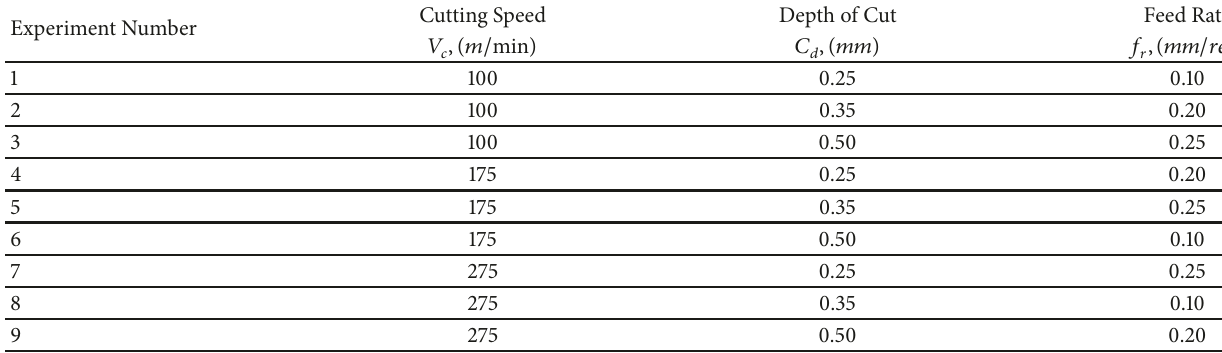
Table 2: Design matrix of variables to the orthogonal array.